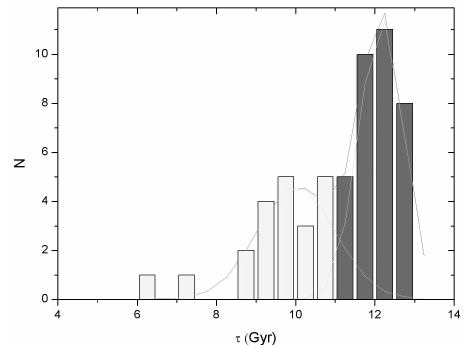
Figure 6: Absolute age distribution for MW GCs. Older GCs, presumably all native in the Milky Way, are evidenced in dark grey.